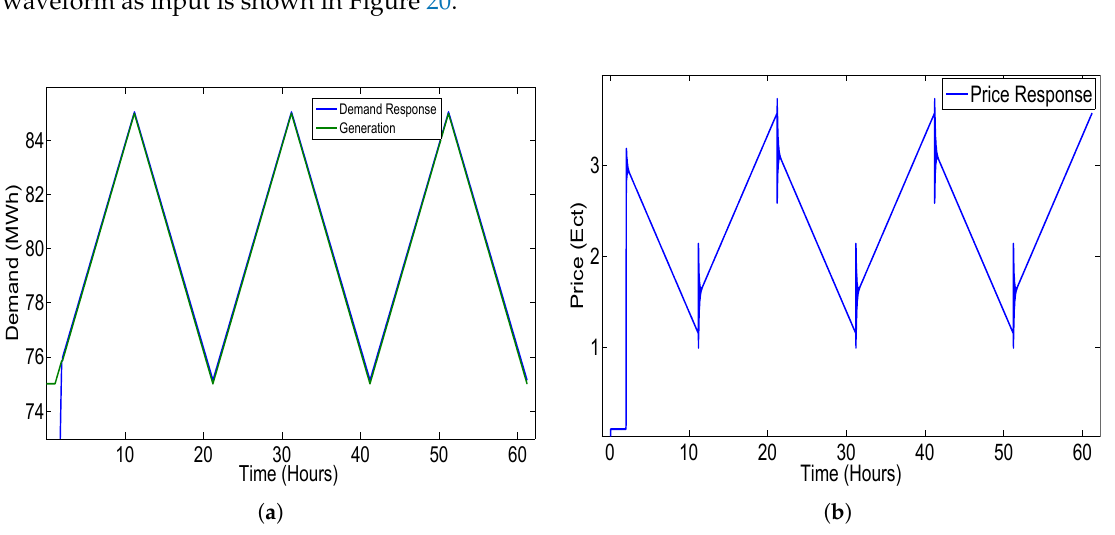
Figure 20. Closed-loop elastic demand control using super twisting sliding mode (STSMC) controller with triangular input having coefficient values K 1 = − 26, K 2 = 0.001 and K 3 = − 30: ( a ) demand response; ( b ) price